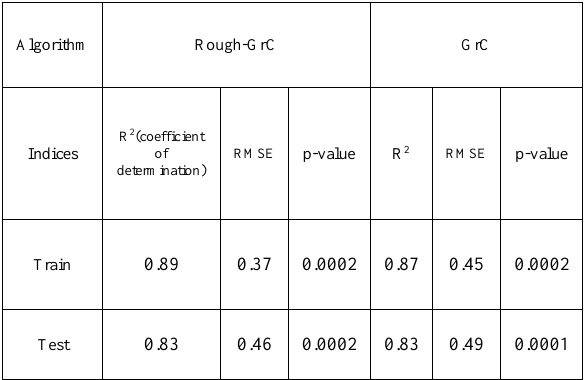
Table 5. Accuracy assessment of the implemented method in comparison with GrC algorithm